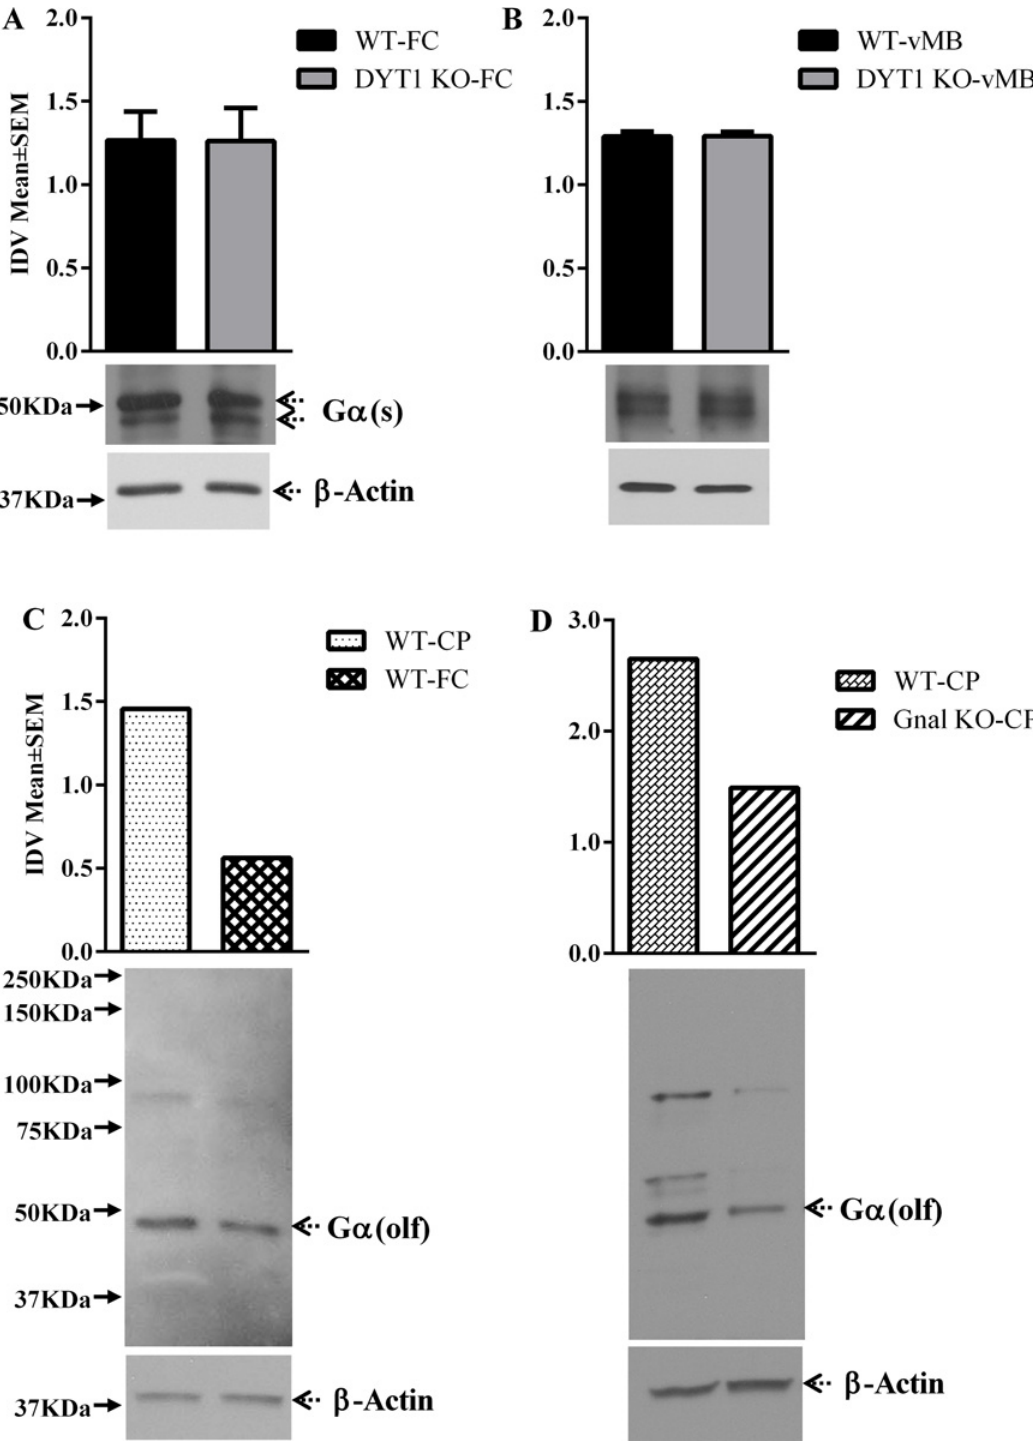
Fig 4. G α (s) and G α (olf) expression at P60. G α (s) and G α (olf) expression in the frontal cortex, caudate-putamen and ventral midbrain of Dyt1 KO and Gnal KO mice at postnatal day 60 (P60; A-D). In each panel, the upper band shows G α (s) (Fig 4A and 4B), and G α (olf) (Fig 4C and 4D), and the lower band shows β -actin, which was used as a loading control. The bar graphs in each panel represent G α (s), and G α (olf) band intensity (mean ± SEM) normalized to intensity of loading control (integrated density value; IDV). The names of the mouse lines ( Dyt1 KO, and Gnal KO) are indicated to the right.